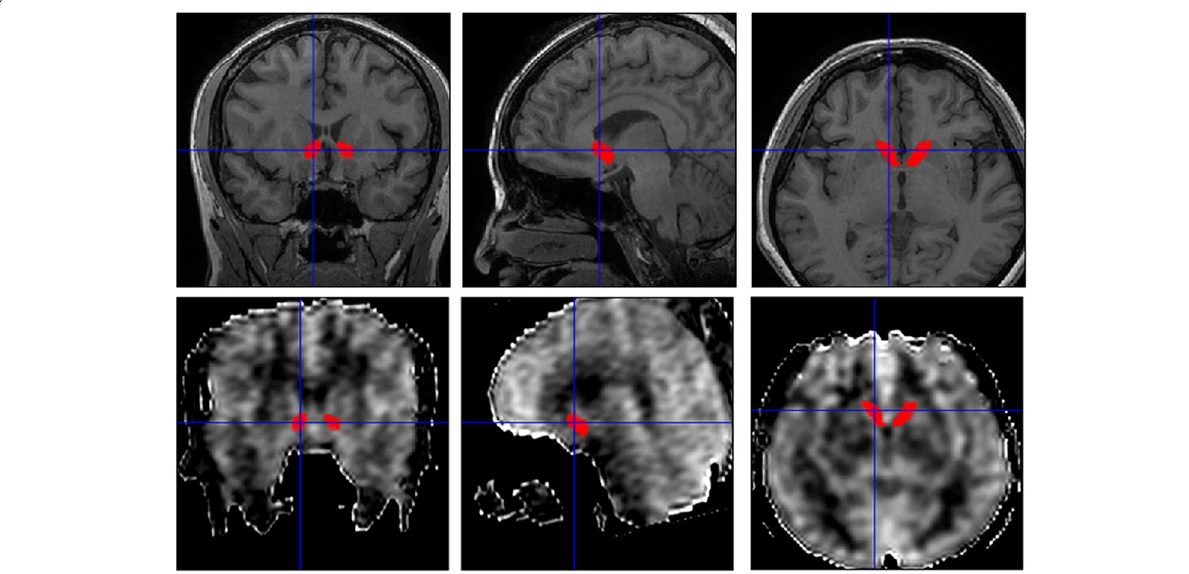
Fig. 1 The individual nucleus accumbens segment. Top line, raw brain structural images; bottom line, raw CBF images co-registered with the brain structural images. Red masks, individual bilateral nucleus accumbenses by applied with inverse deformation